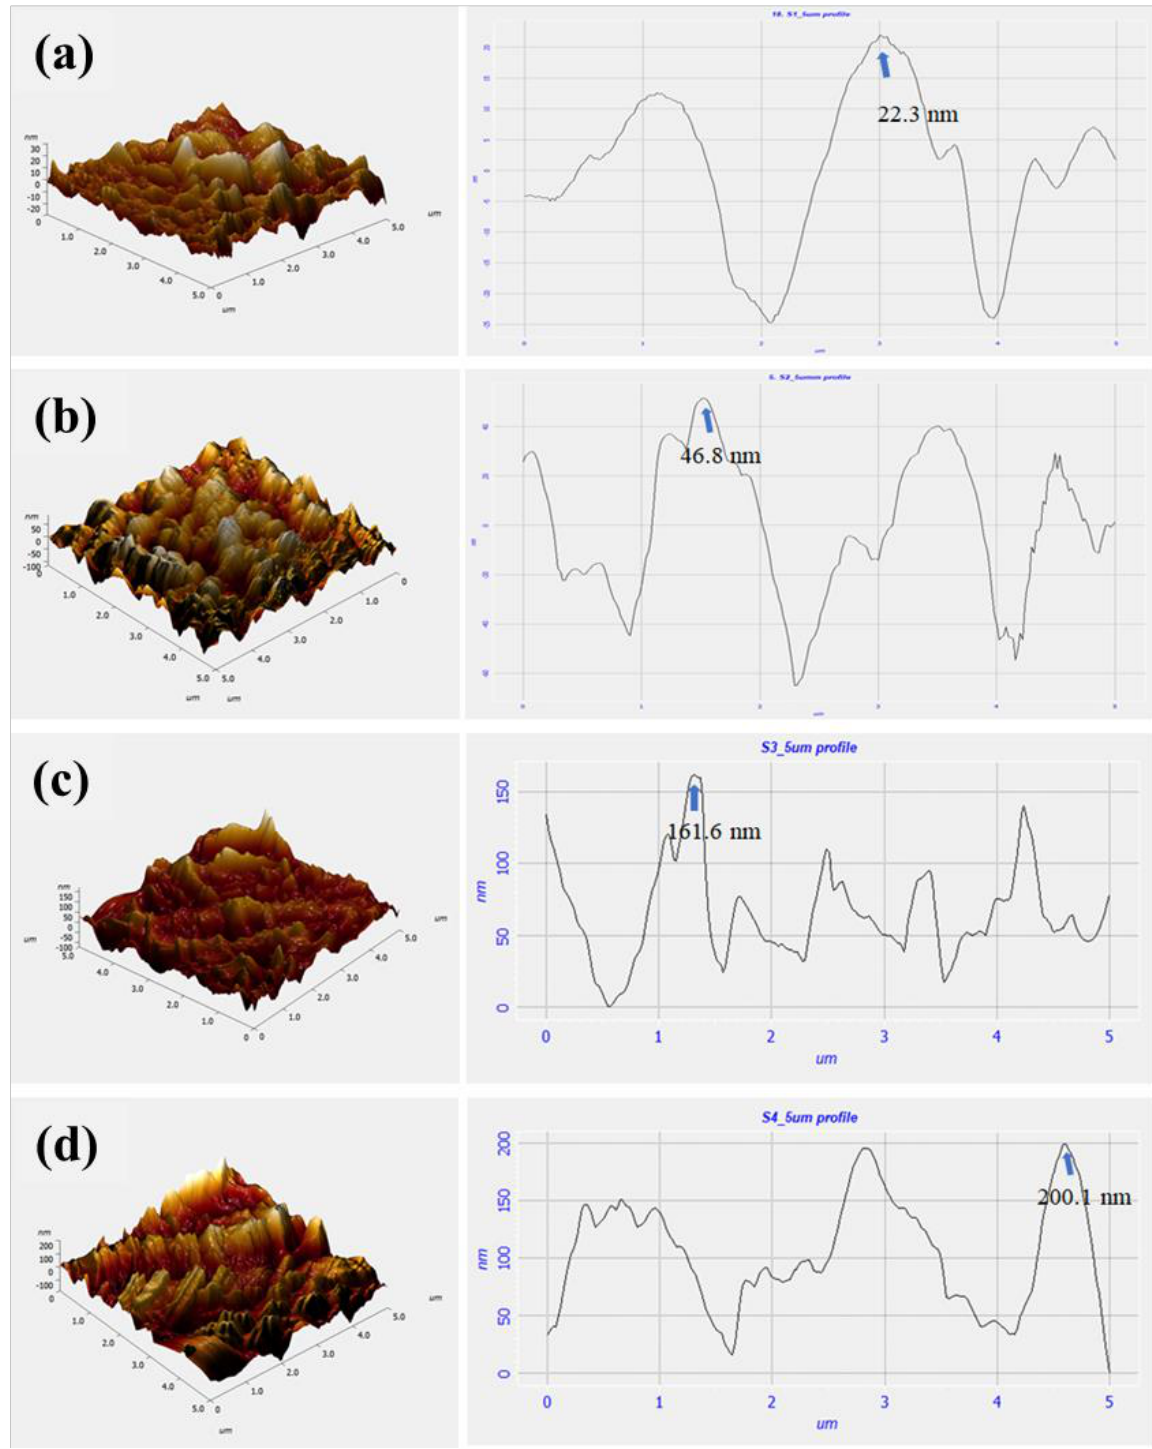
Figure 4. AFM images ( a ) C (z – deflection — 22.3 nm), ( b ) C/DZ (z – deflection — 46.8 nm), ( c ) C/DZ/EDC – NHS (z – deflection — 161.6 nm), and ( d ) C/DZ/EDC – NHS/anti – CR (z – deflection — 200.1 nm) representing the micrograph and corresponding z – deflection.